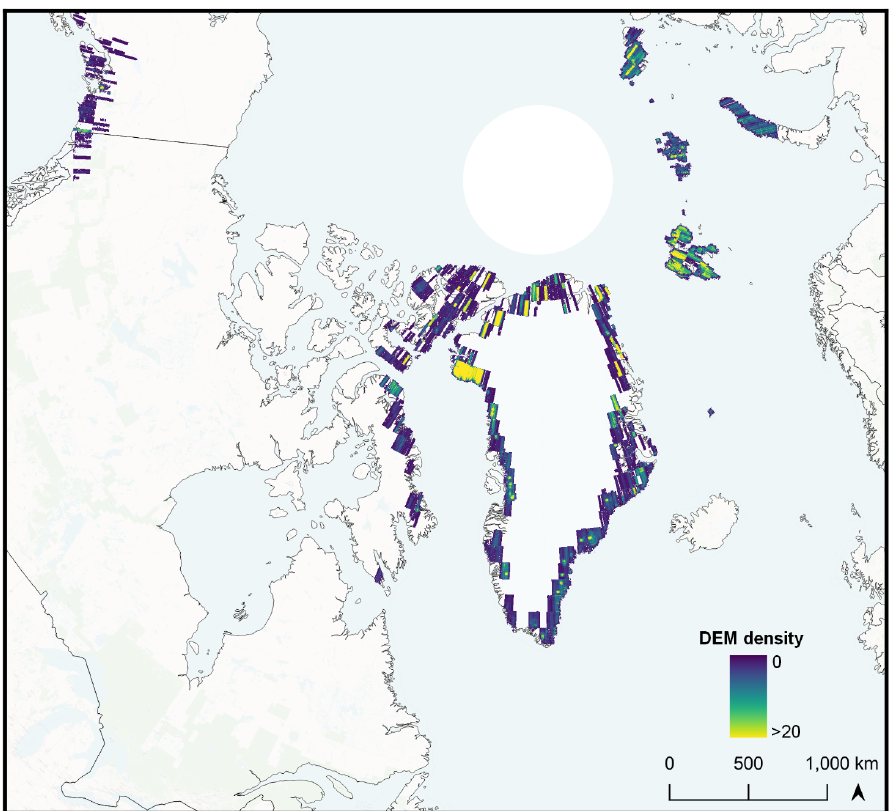
Figure A2. © Google Earth Engine ArcticDEM v3 strip data availability (July–October) for Greenland’s calving margins and all marine/lake/shelf terminating glaciers’ extent in the remainder of the